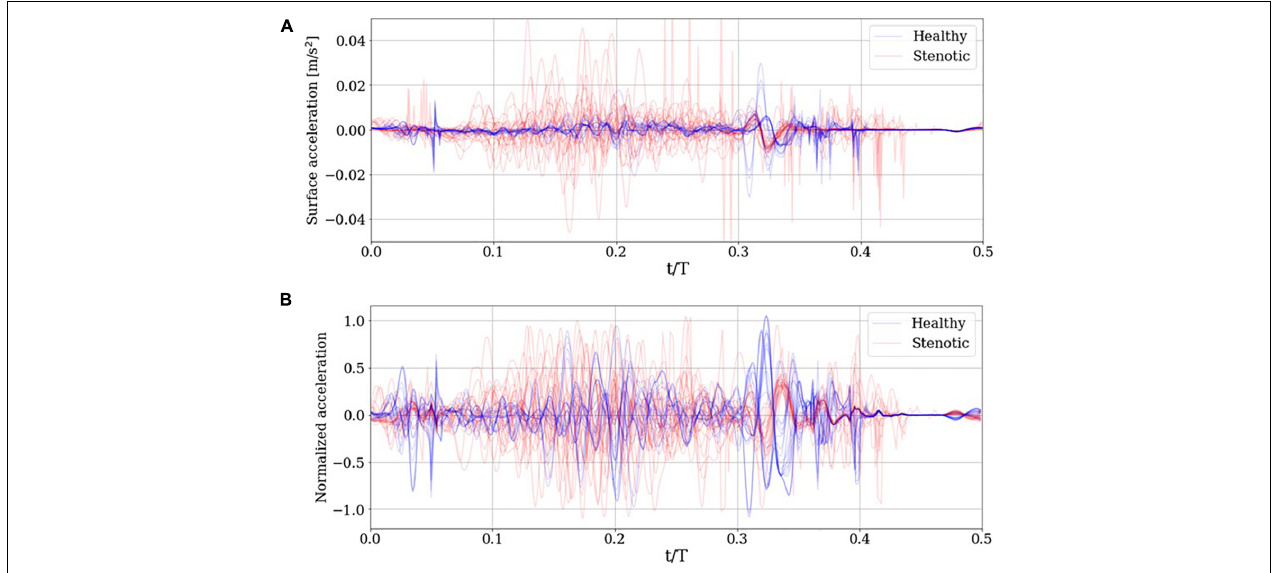
FIGURE 9 | (A) Simulated surface acceleration recorded on the thorax and the (B) corresponding centered and normalized acceleration for the 29 simulations and 15 synthesized healthy signals.